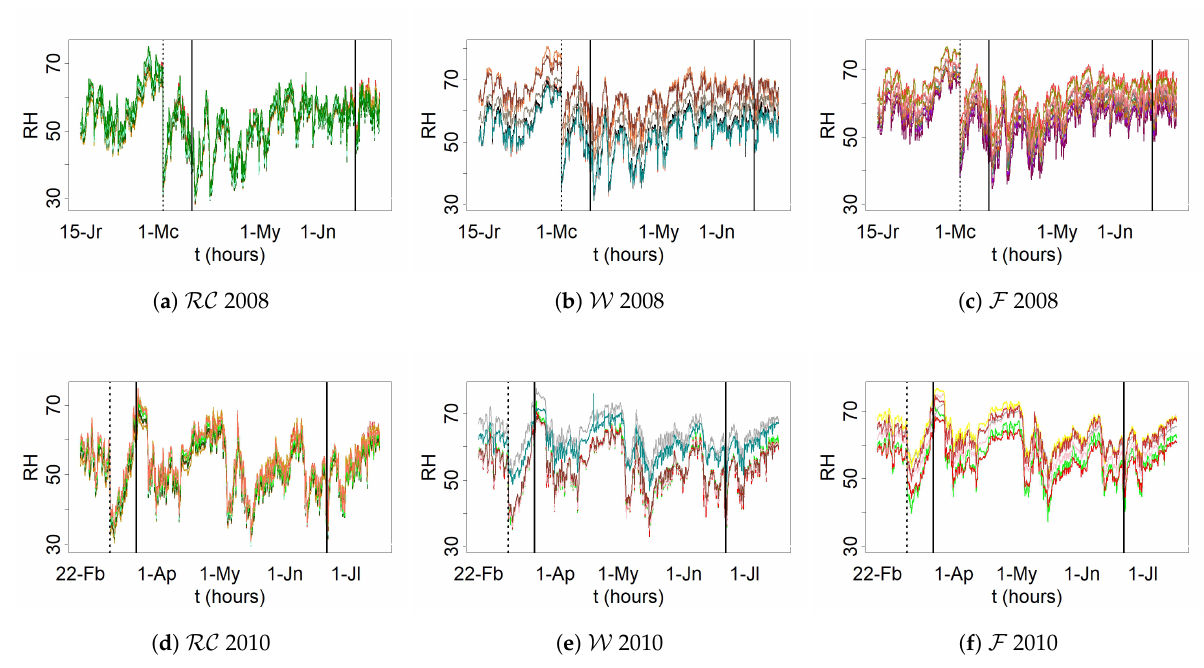
Figure 2. Evolution of RH h . Trajectories of sensors located at equivalent positions in the apse vault are depicted in the same chart (data recorded between January 15 and July 4 2008): cornice and ribs ( RC ) ( a ), walls ( W ) ( b ), and frescoes ( F ) ( c ). Likewise for data collected between February 22 and July 18 2010: RC ( d ), W ( e ), and F ( f ). Separation by seasons (Wr, Sp and Sm) is indicated by means of vertical solid lines. Wr is divided into two periods (dashed line) because a structural break was identified according to the supF and CUSUM tests.